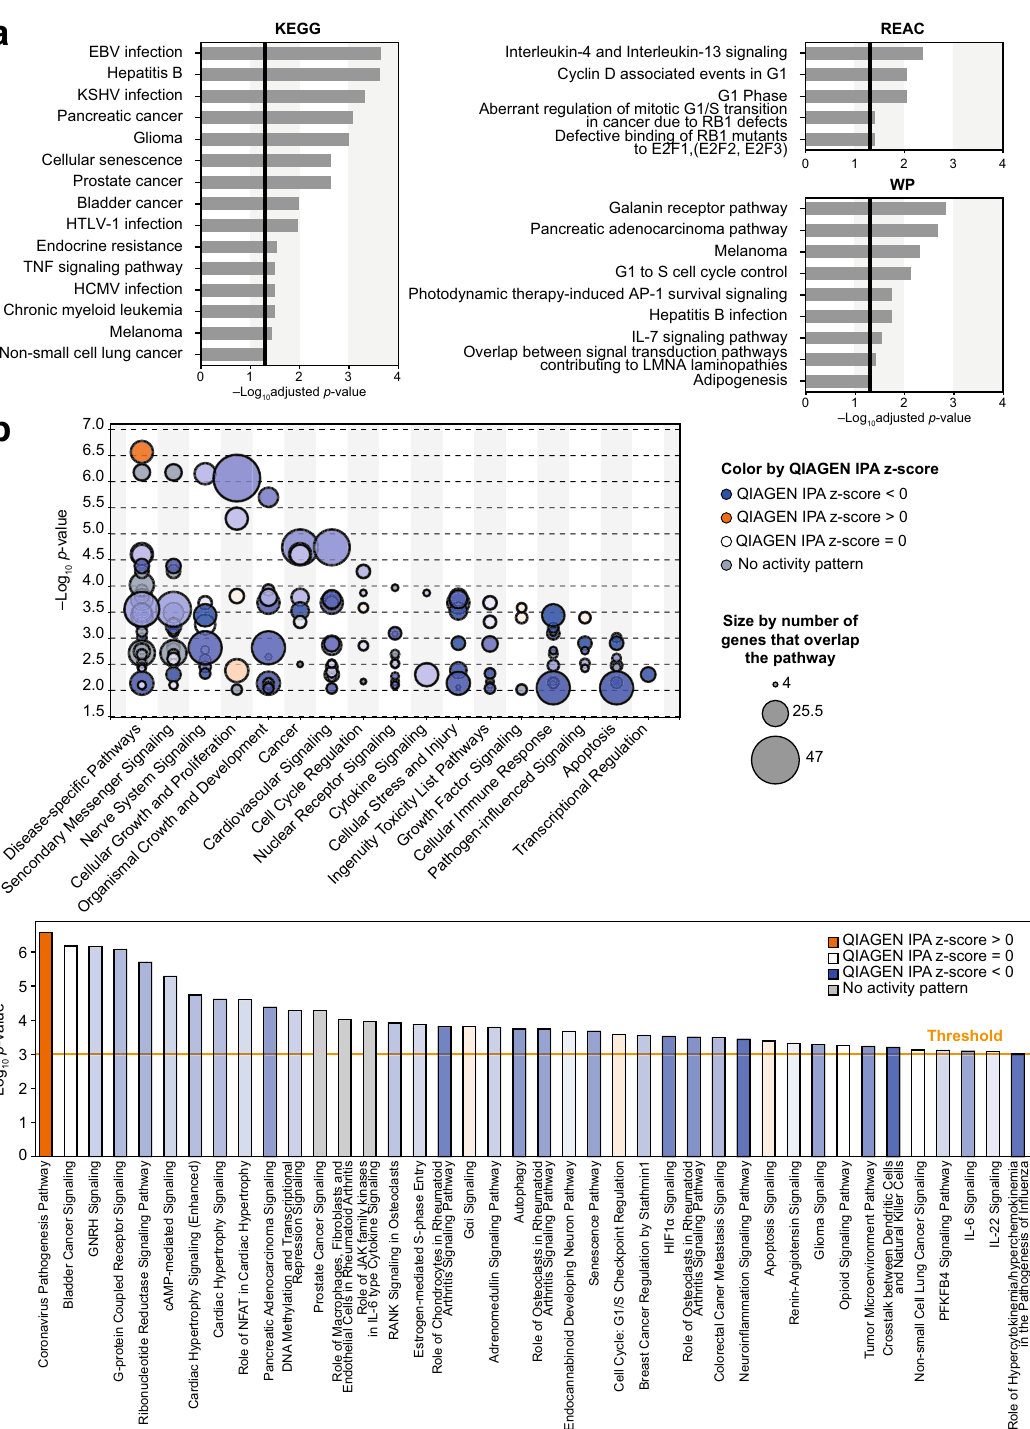
Figure 3. Functional enrichment analysis of potential target mRNAs of DEMs in patients with SD. ( a ) GO analysis of target mRNAs using g:GOSt of gProfiler. Three data sources were used: Kyoto Encyclopedia of Genes and Genomes (KEGG), REACTOME (REAC), and WikiPathways (WP). The vertical black lines indicate the threshold for the adjusted P -value ( Q < 0.05) (See Supplementary Table S3). ( b ) Bubble (top) and bar (bottom) charts based on Canonical Pathway scores arranged by the IPA categories using SD-regulated target mRNAs of DEMs. Orange and blue-colored bubbles or bars: pathway activation or predicted inhibition, respectively, based on QIAGEN IPA z-score, gray bars: pathways for which no prediction could be made because of insufficient evidence in the Knowledge Base for confident activity predictions across datasets, white: pathways with QIAGEN IPA z-scores at or very close to 0. The bubble size corresponds to the number of overlapping genes in each pathway (shown at the extreme right). The P -value was calculated using right-tailed Fisher’s exact test, such that taller bars equate to increased significance. The threshold of − log( P -value) in the bar chart is